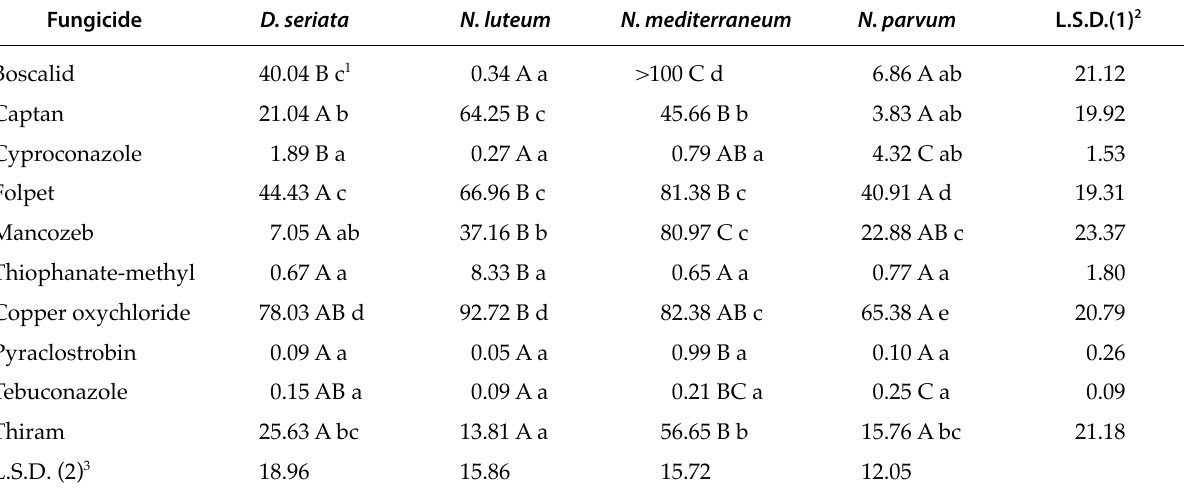
Table 2. Mean EC -1 ) s for in vitro inhibition of mycelium growth of Diplodia seriata, Neofusicoccum luteum , N. mediter- 50 (mg L raneum and N. parvum on potato dextrose agar amended with fungicides.